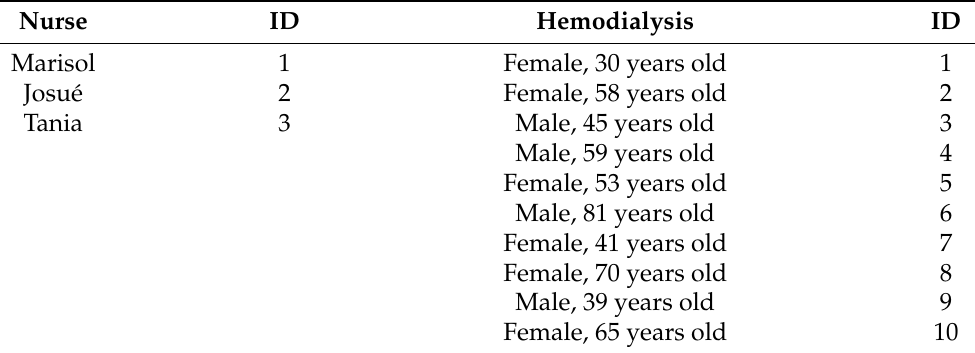
Table A5. Nurses and hemodialysis to be scheduled in artificial kidneys.